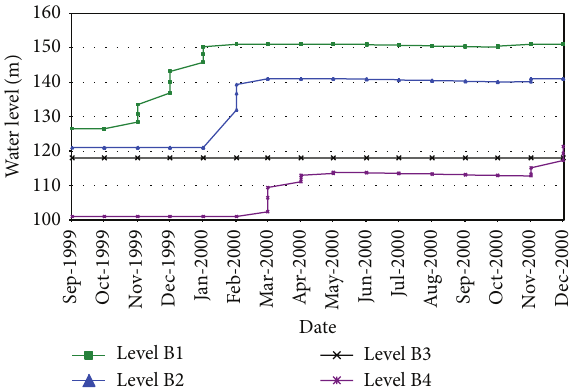
Figure 17: Water levels during the second flood period.